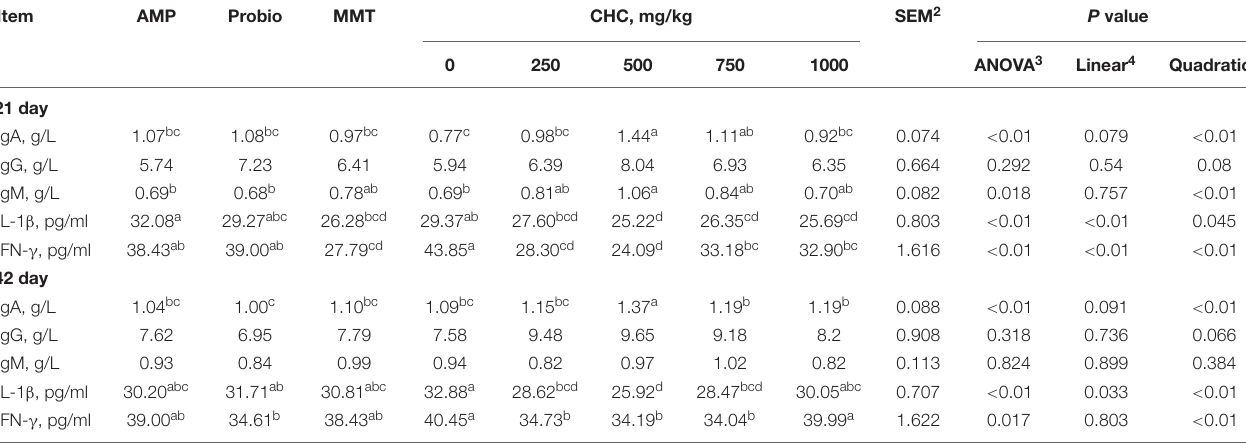
TABLE 3 | Effects of CHC on serum immunological parameters in broilers ( n = 6) 1 .